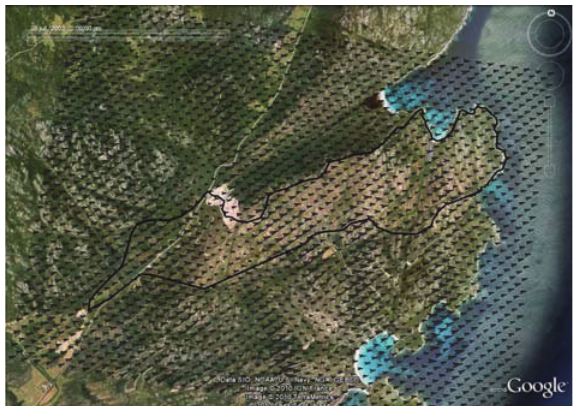
Figure 7: Wind fields for the case study of Suartone Fire. Figure 8: Simulated and observed intermediate time of fire advance for Favone fire with final observed perimeter and calculated wind field in black (Points A, B, and C correspond to the observed times).